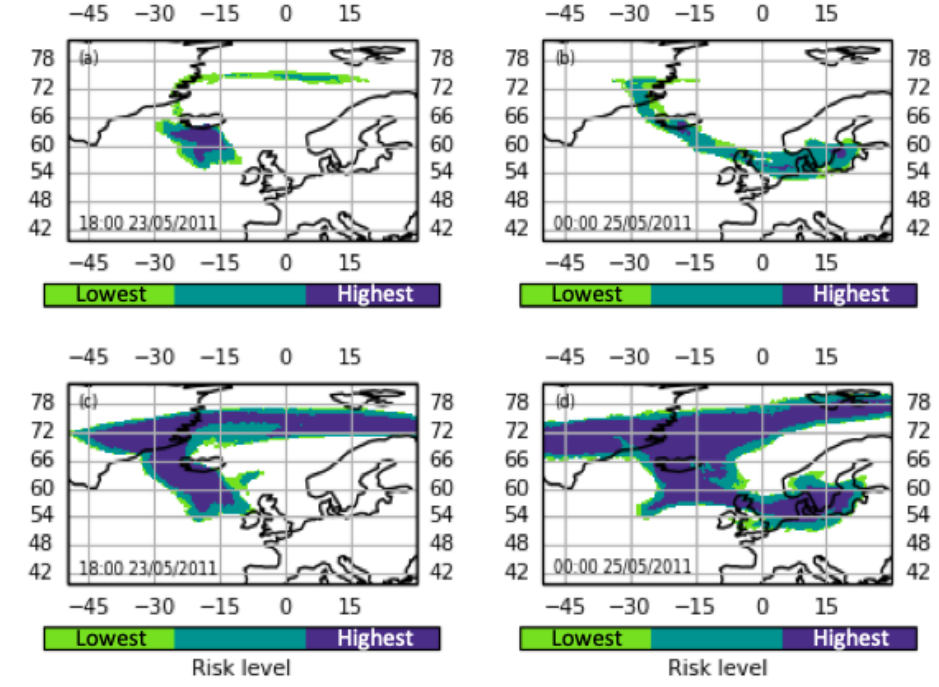
Figure 10. Overall ash concentration risk map at ( a , c ) 1800 UTC on 23 May 2011, ( b , d ) 0000 UTC on 25 May 2011 for ( a , b ) simulations with posterior emissions with matching ensemble meteorology and ( c , d ) simulations with a priori emissions with ensemble meteorology. Green shading indicates the lowest level of risk, turquoise shading indicates mid-level risk and purple indicates the highest level of